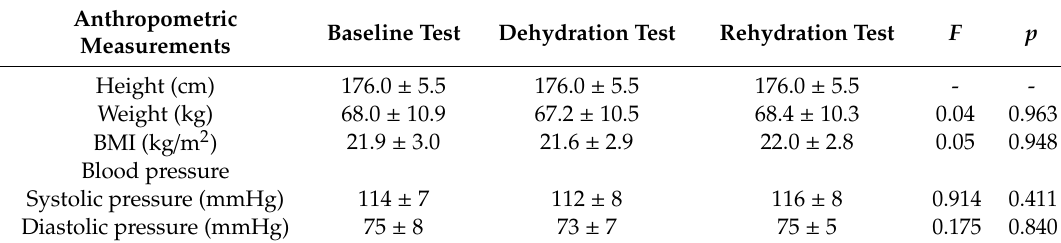
Table 1. Anthropometric measurements of subjects.